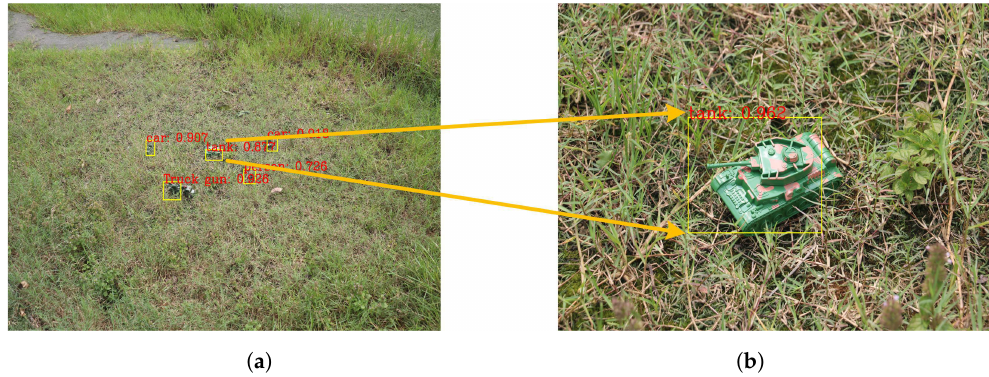
FOV.( a ) ( b ) Figure 13. Target recognition in the imaging system. ( a ) Target recognition results of wide FOV. ( b ) Target recognition results of narrow